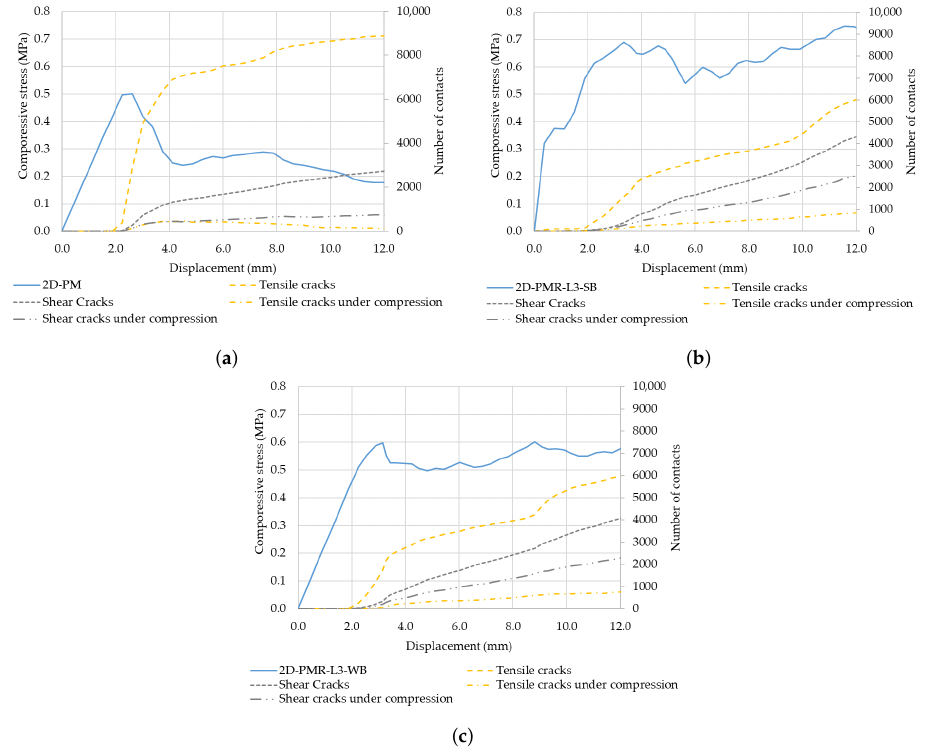
Figure 8. Results of the URM and reference RM 2D-PMR models: stress–displacement diagram and crack evolution. ( a ) Without confinement; ( b ) Three levels–strong bond; ( c ) Three levels–weak bond.